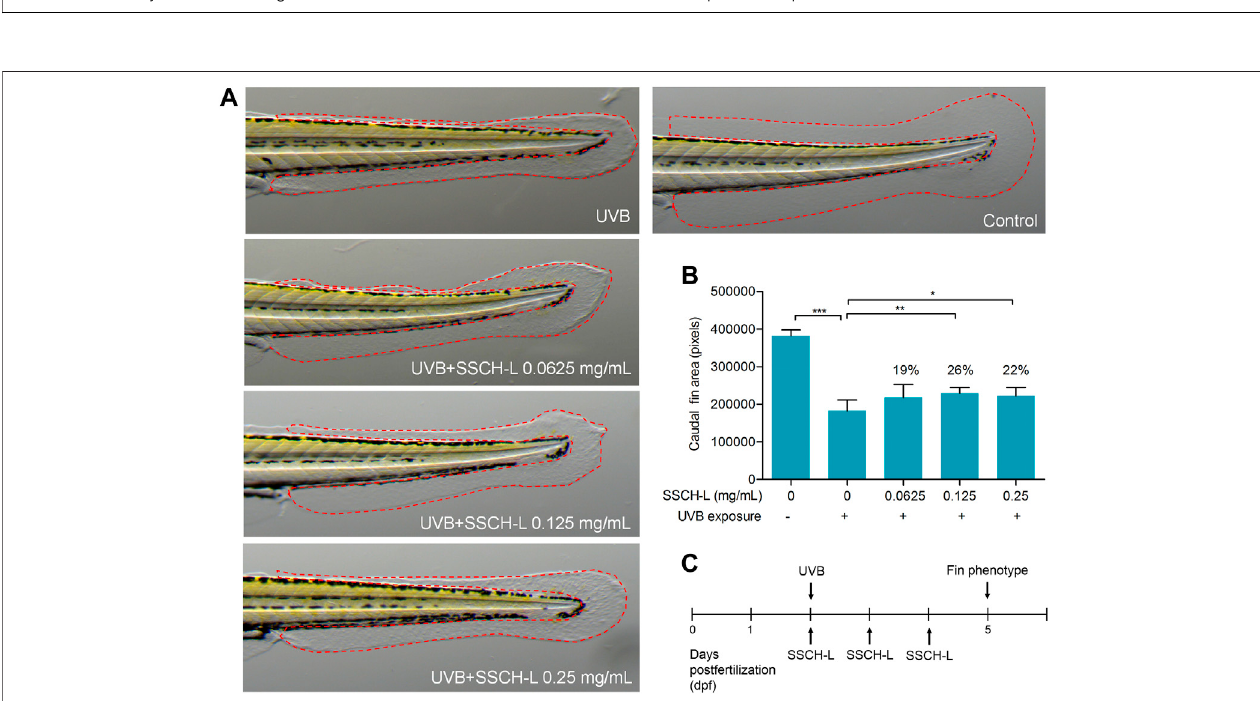
FIGURE9| ThepotentialofSSCH-Ltorepairskindamageinzebra fi shexposedtoUVB. (A) .UVB-inducedmalformed fi nphenotypescanbeattenuatedbySSCH- L. (B) . Quanti fi cation of fi n phenotypes. (C) . Schematic representation of the zebra fi sh experimental protocols performed in this study.